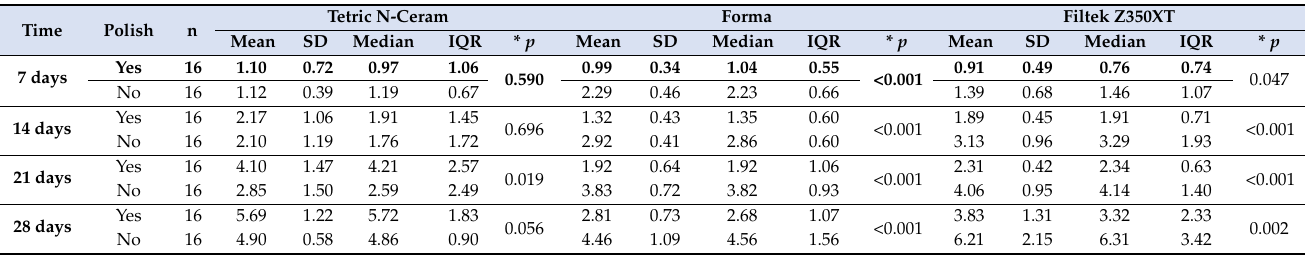
Table 2. Color variation ( ∆ E) comparison of each resin composite with and without polishing according to